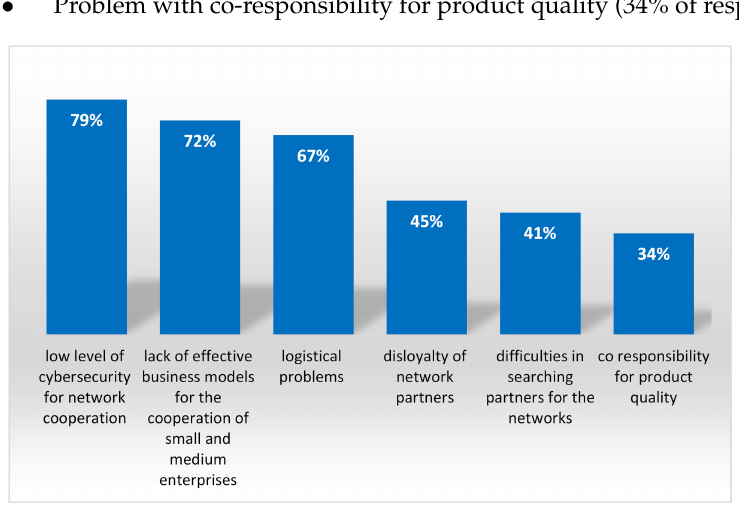
Figure 5. Main problems with network cooperation. Source: own